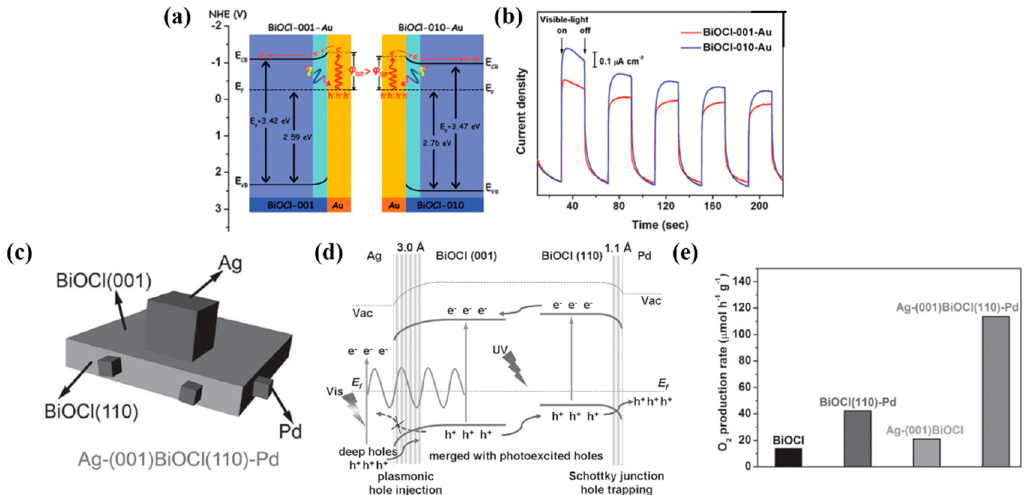
Figure 10. The design for the specific contact of the crystal face between the plasmonic metals and the semiconductor. ( a ) The scheme of the bending degree of the band structures and ( b ) the measurement of the current density in BiOCl-001-Au and BiOCl-010-Au. ( a , b ) Reproduced with permission. [105] Copyright 2015, The Royal Society of Chemistry. ( c ) The scheme of the band structures and ( d ) the structural design in Ag-(001)BiOCl(110)-Pd hybrid structures. ( e ) The rates of the photocatalytic oxygen production in BiOCL, BiOCl (110)-Pd, Ag-(001) BiOCl and Ag-(001)BiOCl(110)-Pd. ( c – e ) Reproduced with permission. [106] Copyright 2015, Wiley-VCH.